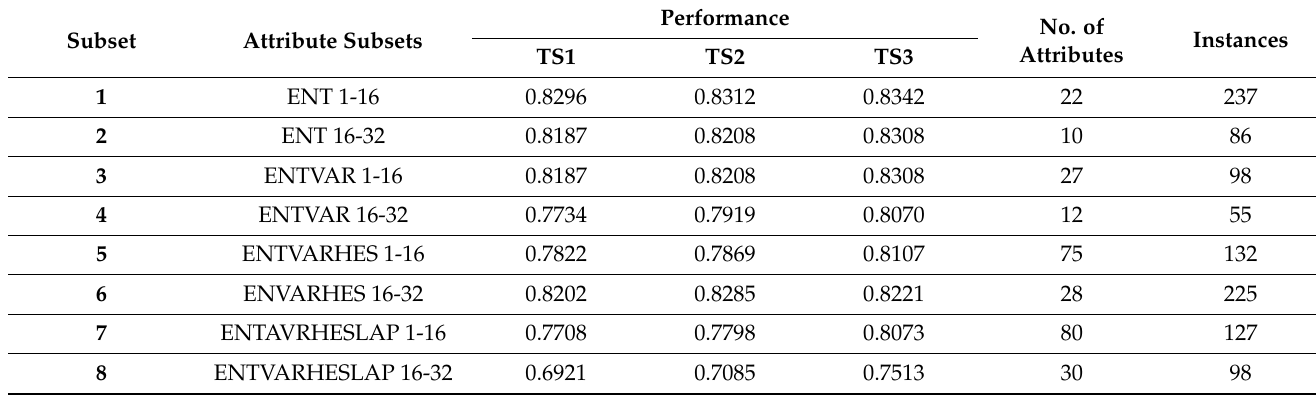
Table 2. Evaluation of the performance of different attribute subsets on test sets (TS1-TS3). Performance is calculated as mean of ACC, TPR, TNR and